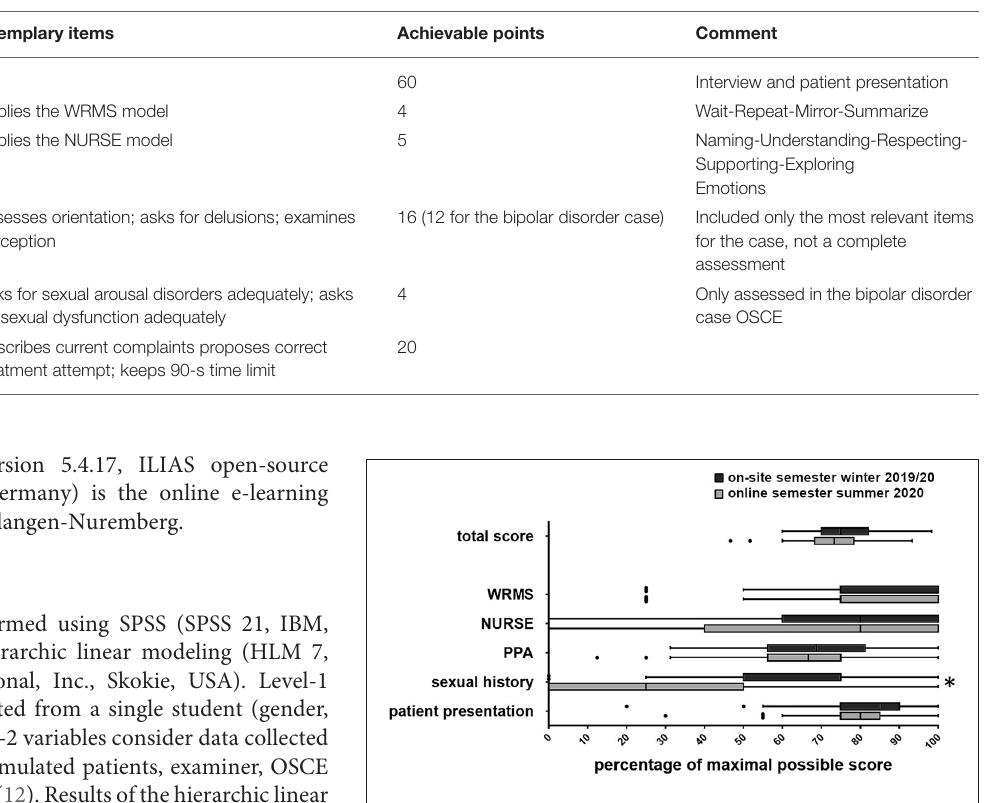
TABLE 1 | OSCE performance scores: composition of the compared scores with exemplary tested items and achievable number of points.